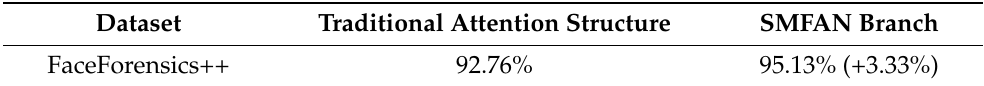
Table 6. Comparison of accuracy of directly introducing attention and using of SMFAN branch on the FaceForensics++ dataset.